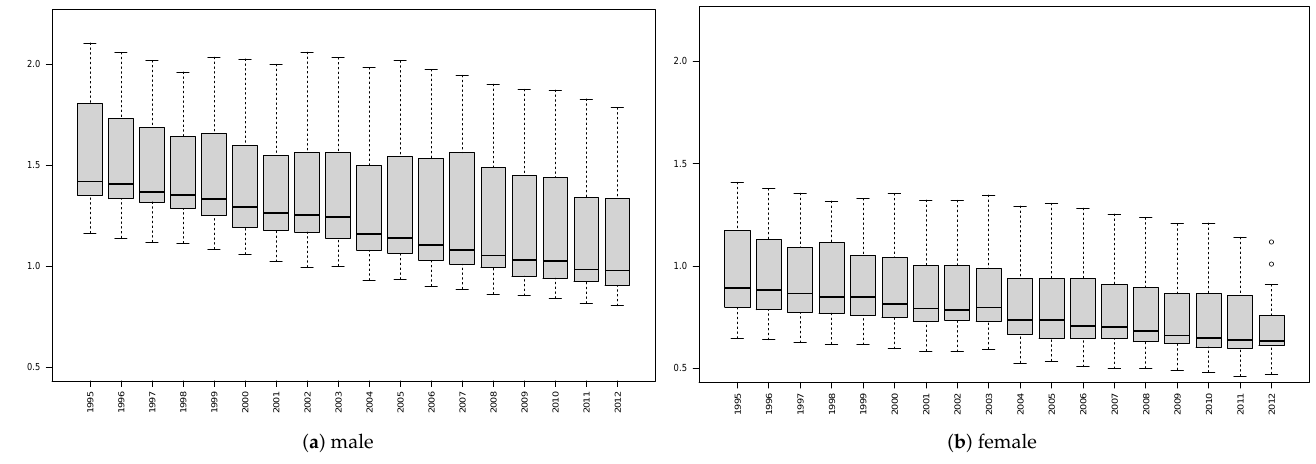
Figure 4. CMF’s variability in Europe for each country for males and females.